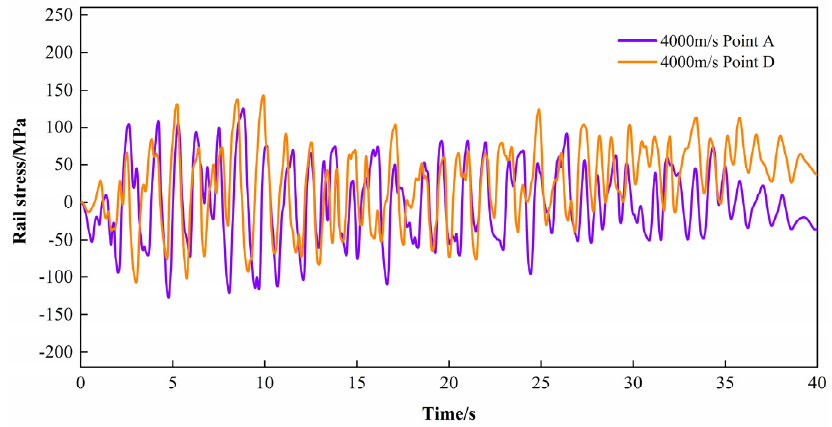
Figure 14. The stress–time-history curve of the rail at point A and point D when the apparent wave velocity is 500 m/s.